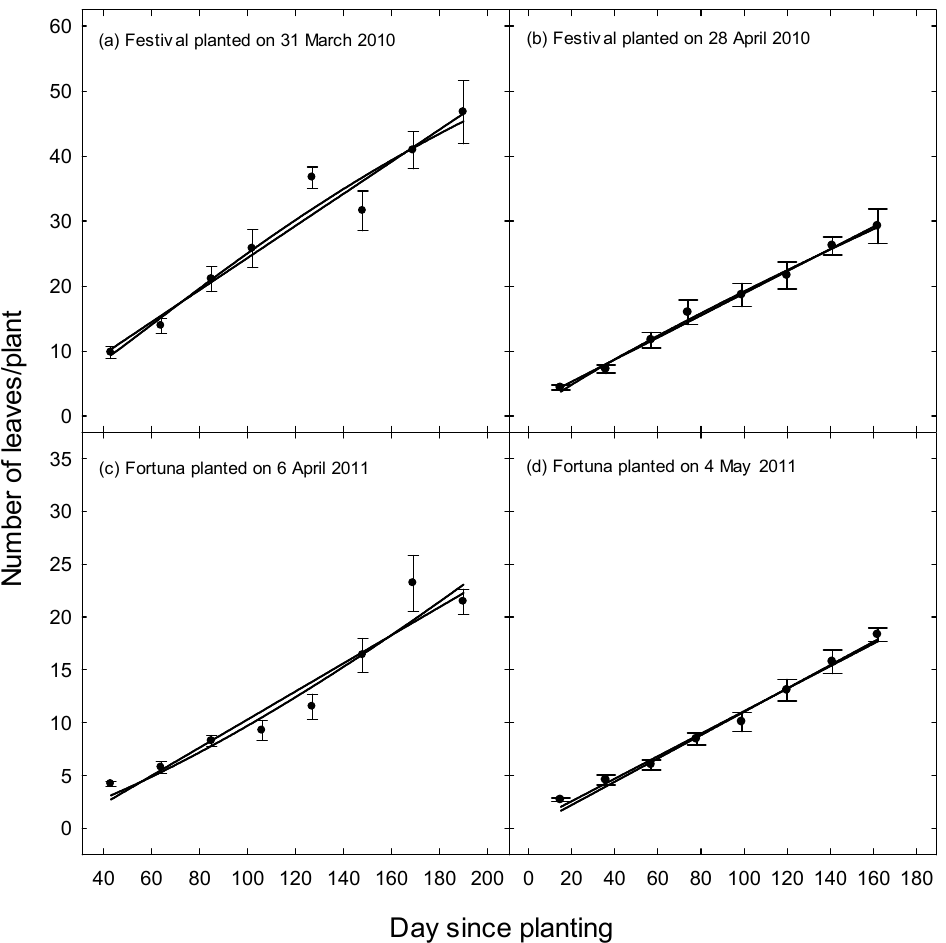
Figure 1. Changes in leaf production in ( a , b ) ‘Festival’ and ( c , d ) ‘Fortuna’ strawberries in Queensland in 2010 and 2011. Data are the means and standard errors (SEs) of four replicates per treatment. Linear and dose-logistic models shown, with information on the regressions provided in Table 3 (Experiments 7a, 7b, 10a and 10 b).